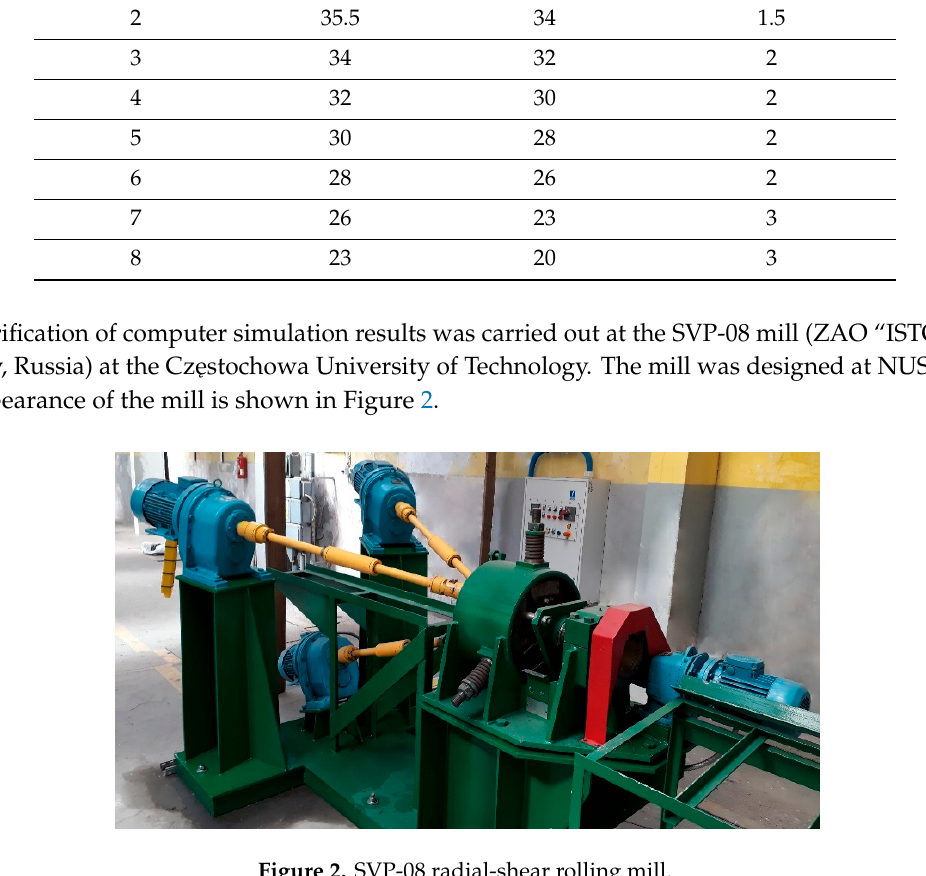
Figure 2. SVP-08 radial-shear rolling mill.